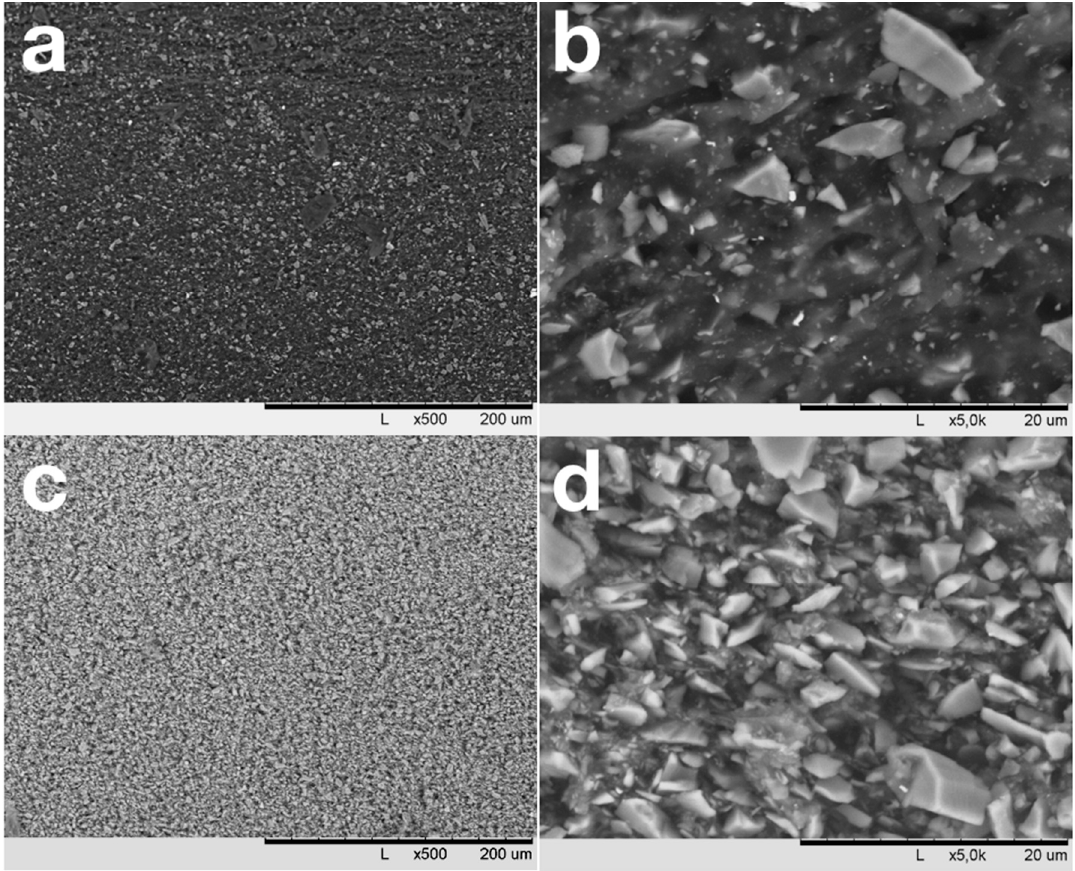
Figure 2. SEM images of vulcanized samples with filling degrees of 50 ( a , b ) and 450 ( c , d ) PHR. During low-temperature carbonization of unfilled NBR, a homogeneous, weakly defective black material is formed (Figure 3); the density of the unfilled NBR increases from 0.94 g / cm 3 to 1.07 g / cm 3 during carbonization. As a result of the carbonization, vulcanized NBR loses its ductility and breaks down brittlely under load. The fracture surface was nearly smooth and contained no defects or gas bubbles. Brittle crack evolution steps are clearly visible on the fracture surface.